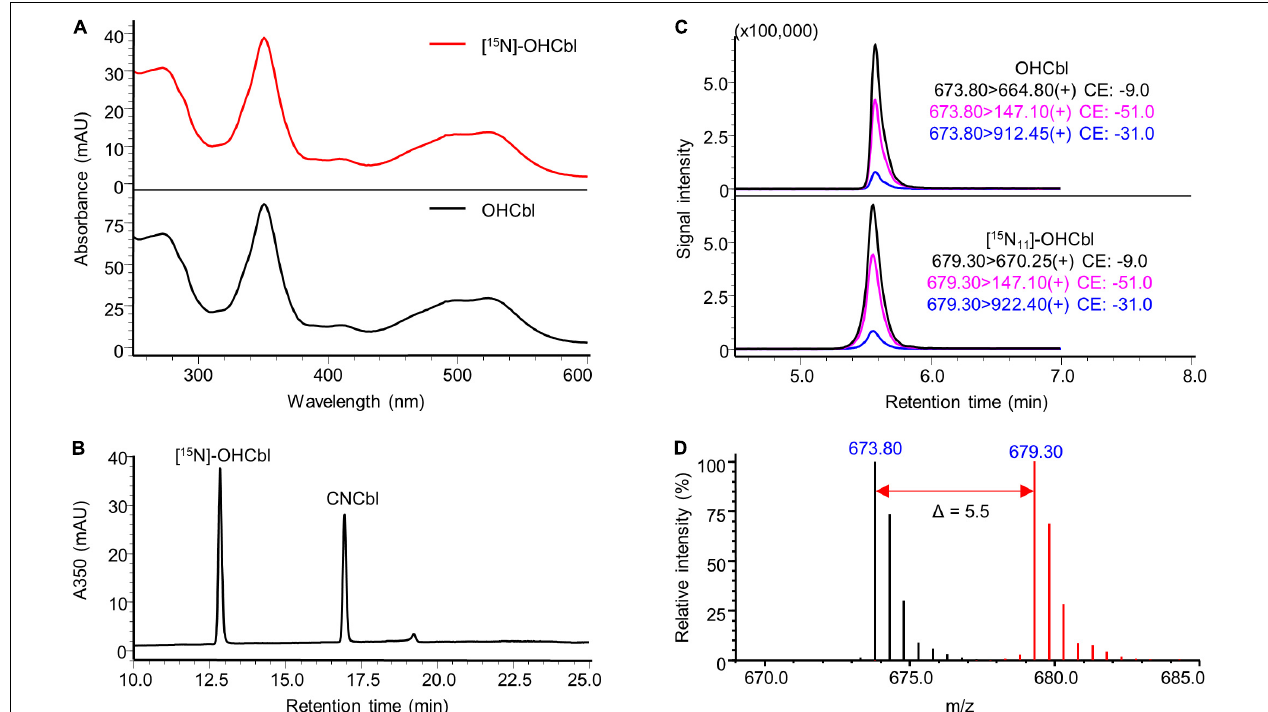
FIGURE 7 | Characterisation of prepared [ 15 N, 14 N 2 -DMB]-OHCbl. (A) UV-Vis spectrum of the prepared [ 15 N, 14 N 2 -DMB]-OHCbl in comparison to that of the OHCbl standard. (B) HPLC-DAD analysis at a wavelength of 350 nm of the prepared substance showed a major peak at the same retention time of unlabelled OHCbl standard (see Supplementary Figure 6 ). CNCbl shown on the chromatogram was added as internal standard to determine the absolute concentration of [ 15 N, 14 N 2 -DMB]-OHCbl. (C) LC-MS/MS analysis of [ 15 N, 14 N 2 -DMB]-OHCbl monitoring mass transitions corresponding to [ 15 N 11 , 14 N 2 -DMB]-OHCbl (lower trace). The LC-MS/MS chromatogram of unlabelled OHCbl is shown as a reference (upper trace). (D) Overlaid mass spectra of [ 15 N, 14 N 2 -DMB]-OHCbl (red) and unlabelled OHCbl (black). The mass shift in [M + 2H] 2 + values indicated by the red arrow confirmed the labelling of 11 nitrogen atoms. MS spectra were acquired in selected ion monitoring (SIM) mode with a m/z interval of